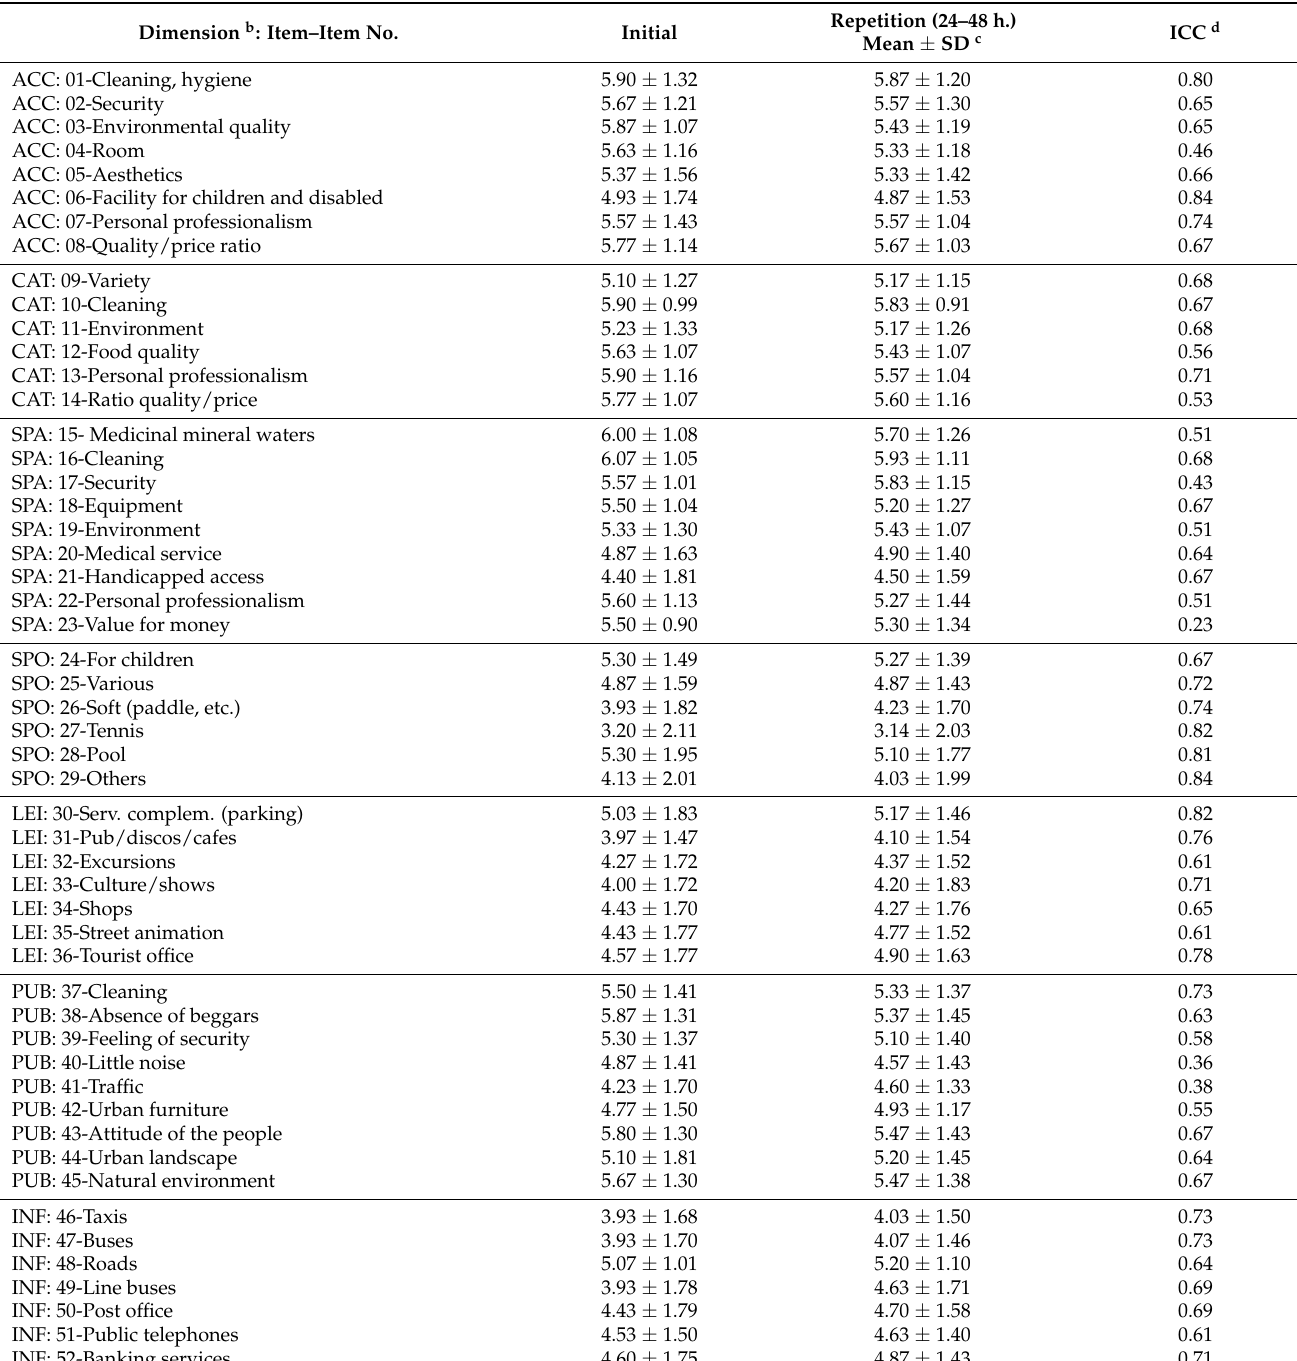
Table 3. Reliability of the 52 items of the main questionnaire. Test–retest (1–2 days apart) ( n = 30 a